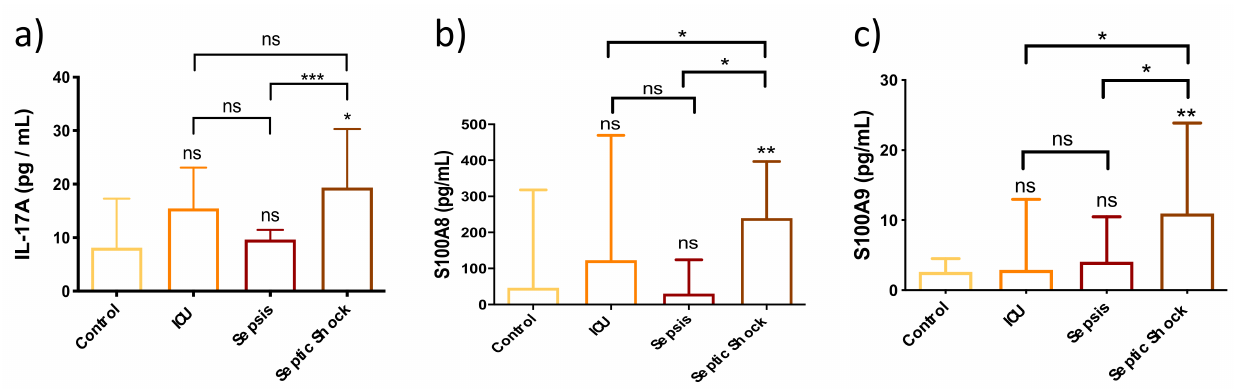
Figure 6. Bar graph (Median ± IQR) of circulating levels of different immunomodulators in control, ICU, sepsis and septic shock patients. ( a ) Circulating levels of IL-17A; ( b ) Circulating levels of S100A8; ( c ) Circulating levels of S100A9. Each sample was measured in duplicate. ns = non-significant p value; * p < 0.05; ** p < 0.01; *** p < 0.001. The lines at the top of the box plots indicate differences between compared conditions. The number of subjects analyzed were as follows: control ( n = 10); intensive care unit (ICU) ( n = 5); sepsis ( n = 10); septic shock (SS) ( n =